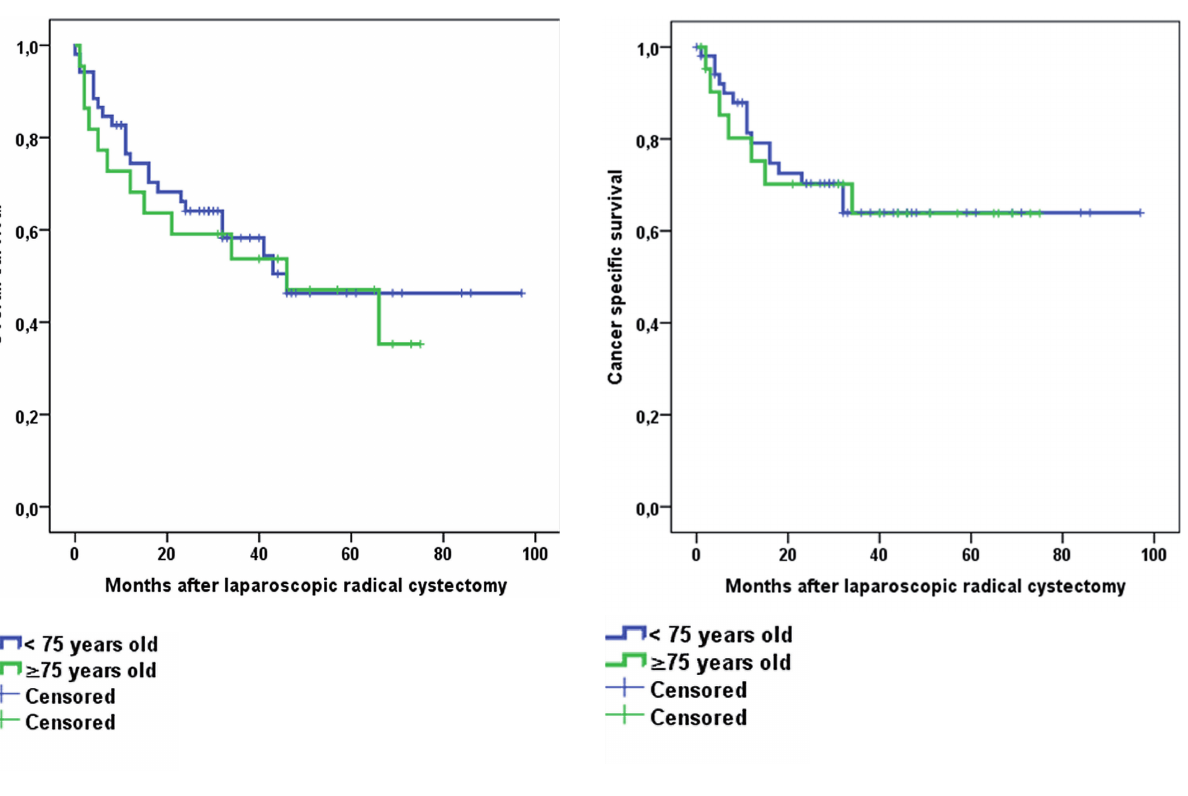
figure 1 – B) cancer specific survival for laparoscopic radical cystectomy for younger vs.